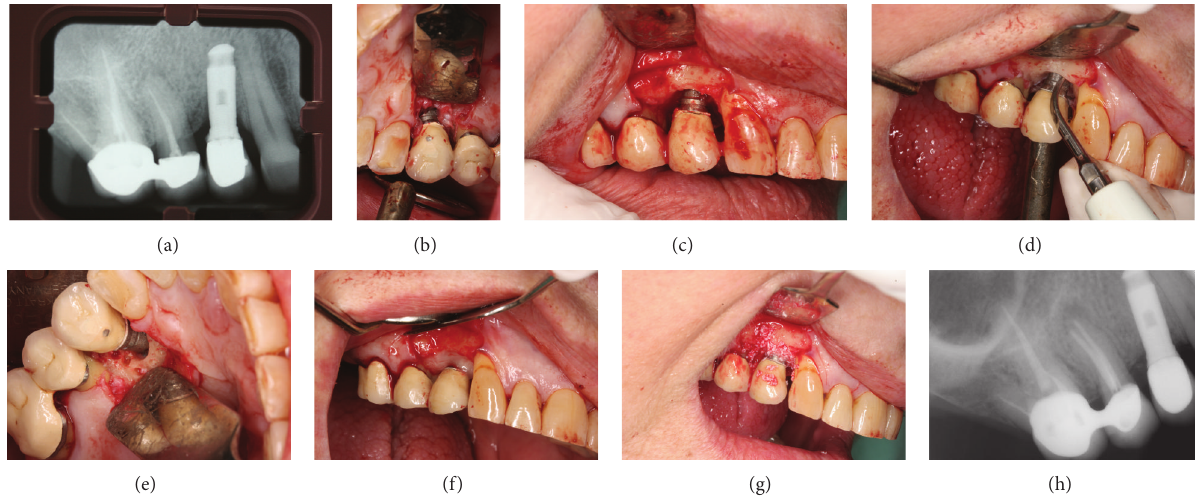
Figure2:Treatmentofperi-implantitisusingaregenerativeapproach.(a)Preop,notetheseverebonelossonimplantatposition#14.(b)Upon reflectionoftheflaps,notethegranulationtissuebutalsoexcesscementumonthecrown’smargin.(c)Followingdegranulation,demonstrating the extent of bone loss. (d) Excess cement was removed and the implant surface was debrided using hand instruments and ultrasonic scaler. (e) Decortication was performed using diamond burs. (f) Surface decontamination was supplemented with the application of 24% EDTA for 3 minutes. (g) The defect was grafted with bovine derived Xenograft (BioOss). (h) 3 years later, complete resolution of the radiographic